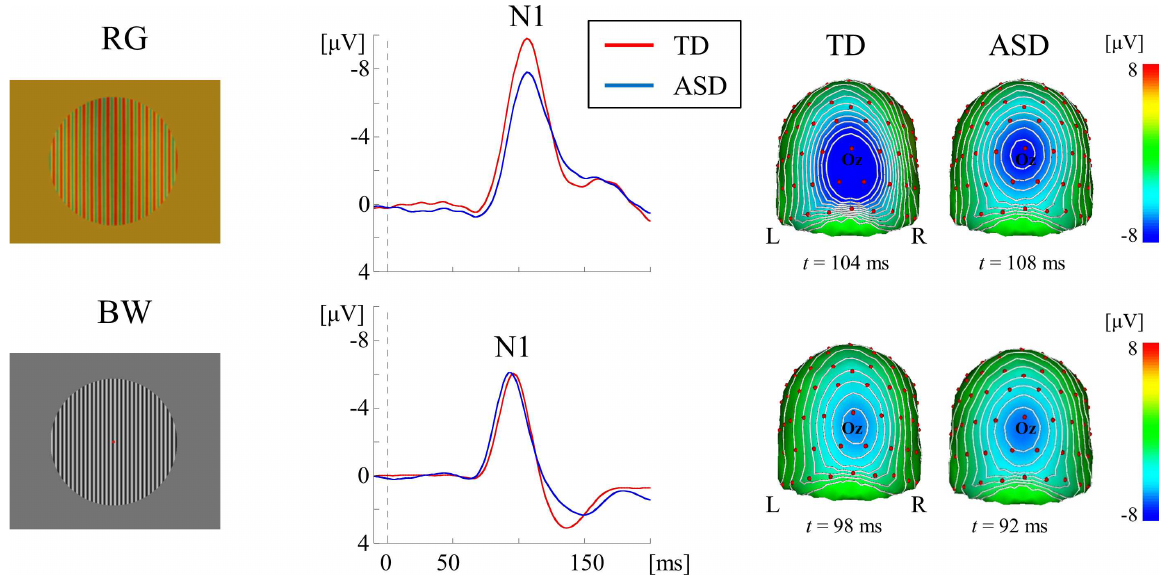
Fig 1. VEPs for RG and BW stimuli at the occipital ROI in each group. Grand-averaged waveforms show that N1 was a major componentin both stimuli. Scalp topographyshows N1 localizedto the occipitalarea. VEPs , visual evoked potentials; RG , red/green; BW , black/white; ROI , regionof interest.